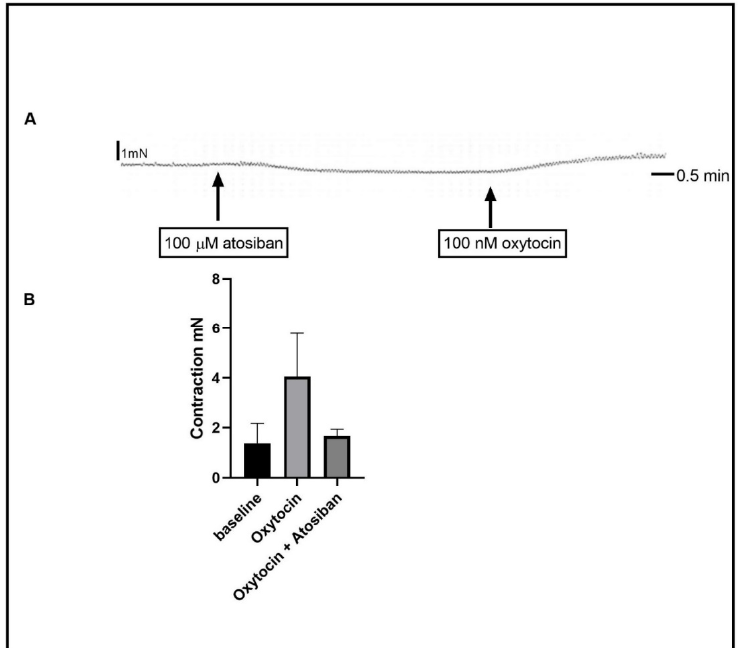
Figure 2. Effect of oxytocin receptor (OR) inhibition on oxytocin-induced contraction. ( A ) is a representative trace demonstrating 100 nM oxytocin-induced contraction after 15 min of incubation with 100 µM of atosiban. It also shows that atosiban did not affect the baseline activity. ( B ) is a summary graph showing oxytocin-induced contraction after incubation with atosiban. Data expression is in mN of force. Values are mean ± SEM. n ≥ 11.